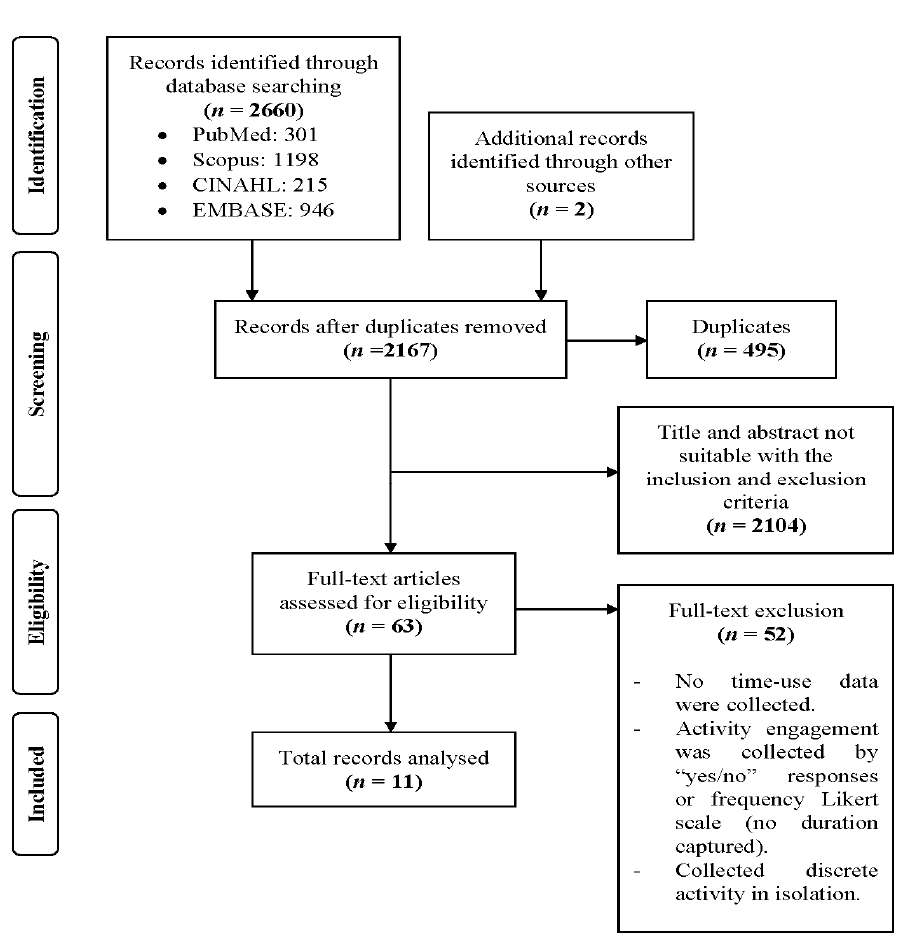
Figure 1. Scoping review flow chart. Table 3. Number of studies published by year.